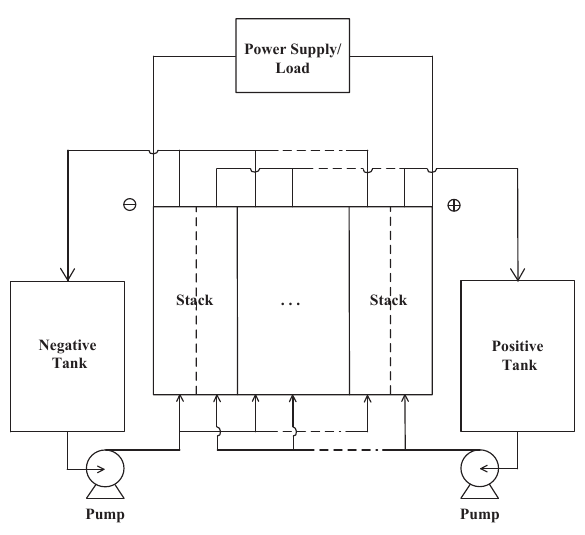
Figure 1. Basic configuration of the vanadium redox flow